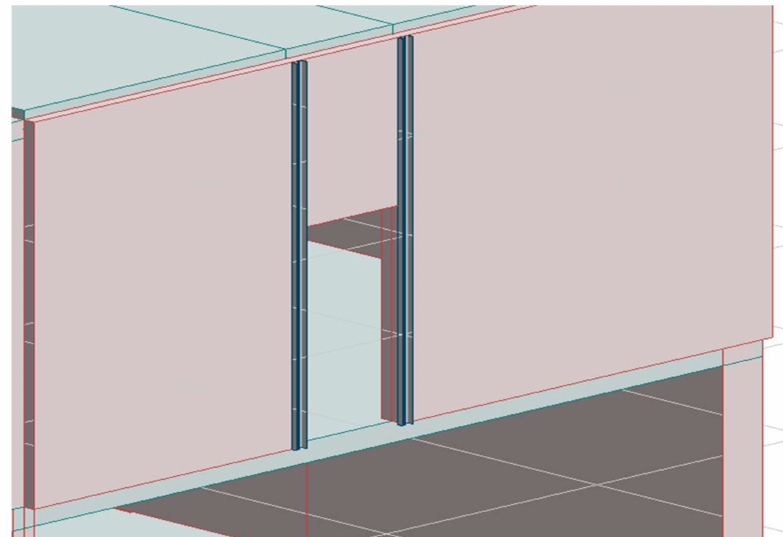
Figure 24. Modeled PSS (U3).